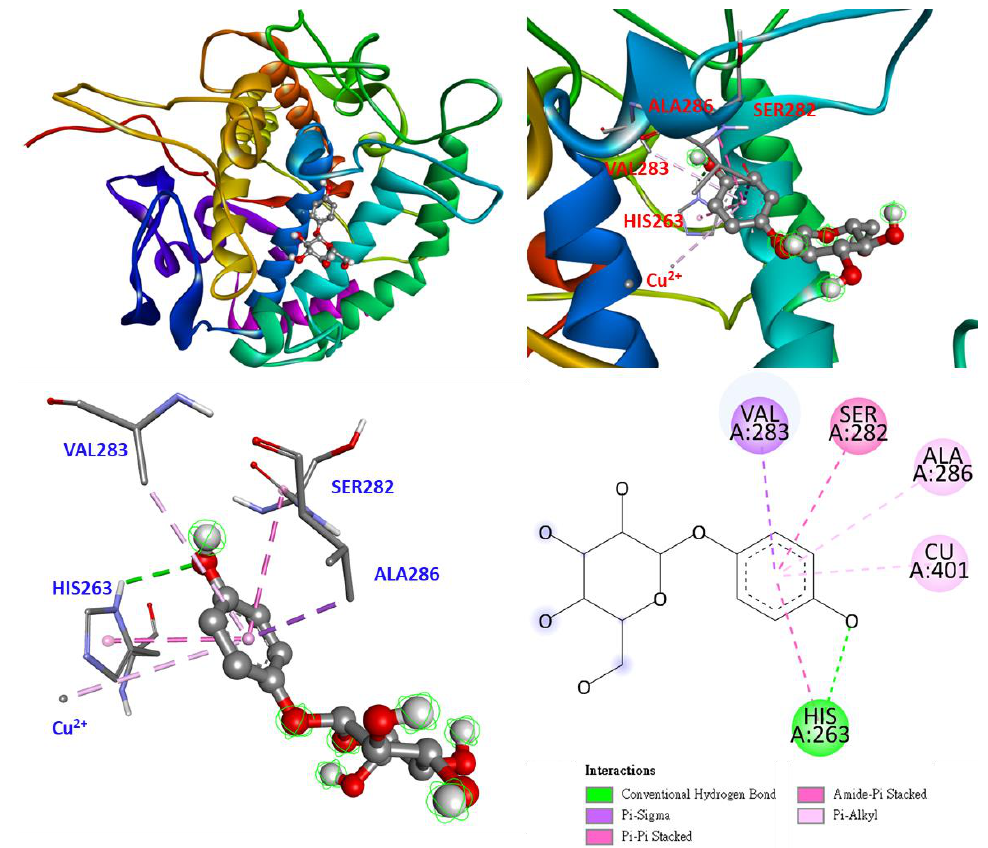
Figure 8. Interaction of arbutin with active sites of Agaricus bisporus tyrosinase.